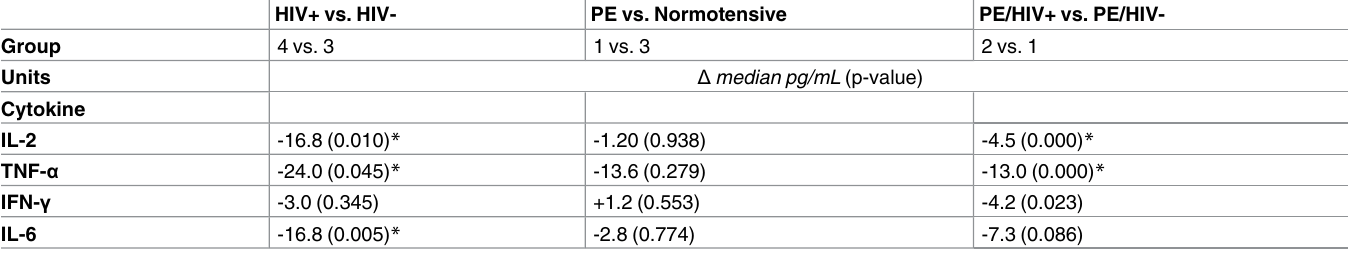
Table 3. Comparative analysis of cytokine perturbations by groups. HIV+ vs. HIV- PE vs.